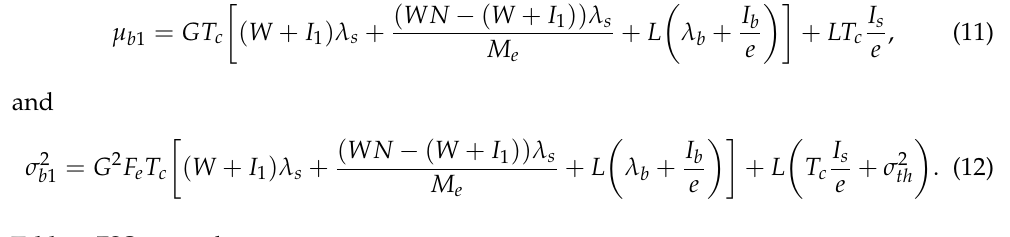
Table 2. FSO network